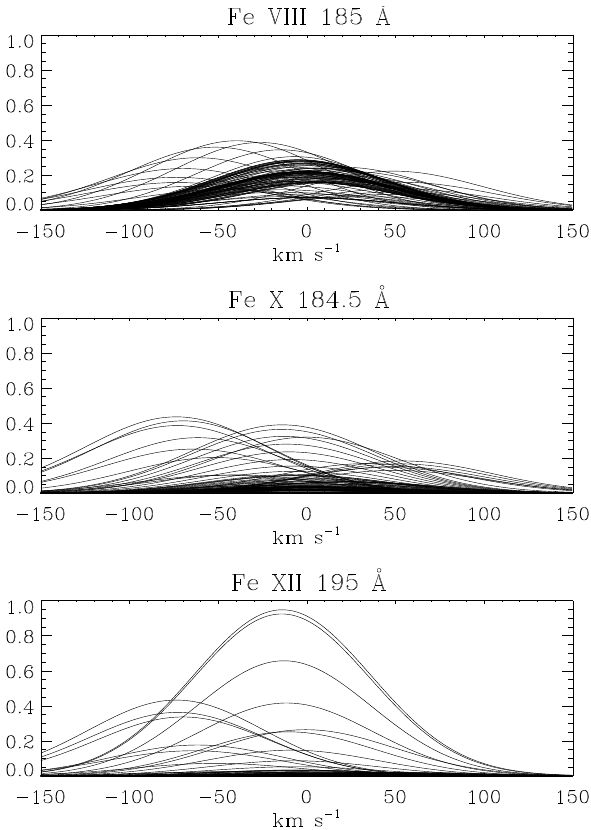
Figure 4. Synthetic line profiles, from a 5000s simulation, for a loop consisting of 1 strand. There is a 50s interval between each plotted